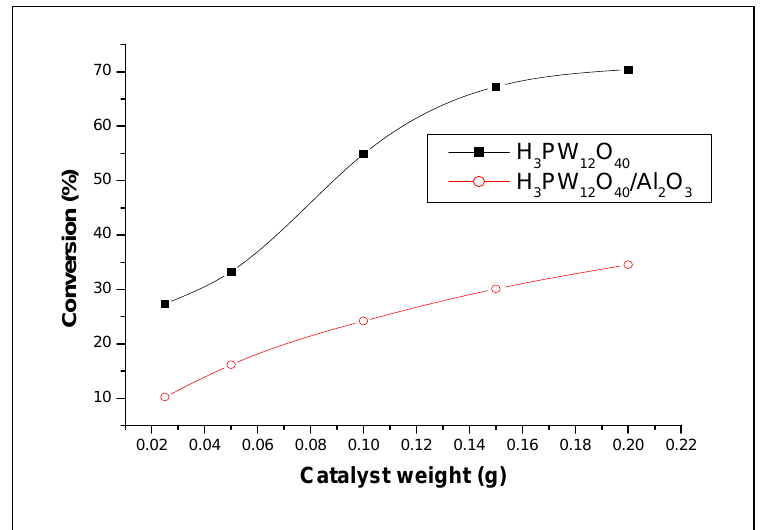
Figure 7. Values of the conversion obtained with the unsupported and the alumina- supported catalysts. Reaction conditions: T = 20 ºC; AA/THF (volume ratio) =